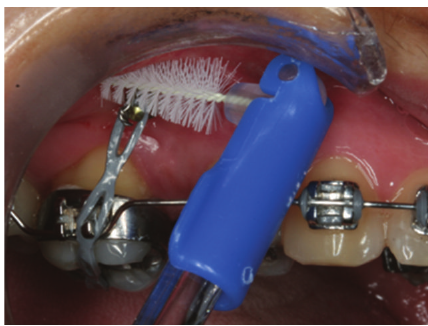
Figure 10: Interdental brush dipped in 0.12% chlorhexidine during OI hygiene control.